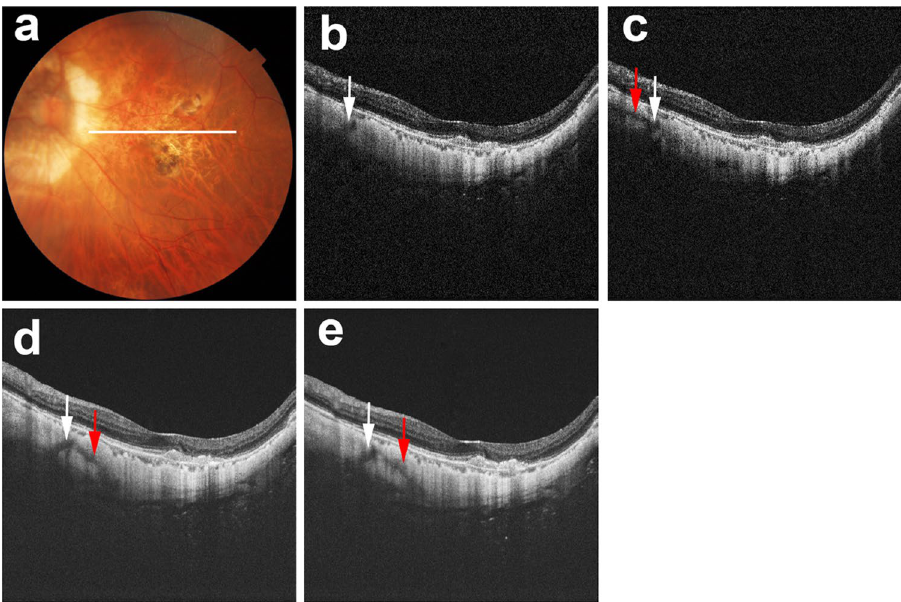
Figure 5. Scleral vessel artifacts in different locations in polarization-dependent OCT images and commercial OCT images. The left eye of a 75-year-old woman with myopic choroidal neovascularization in remission is shown. White line in color fundus image ( a ) indicates the scan line for PD-OCT images and commercial OCT B-scan images ( b – e ). Polarization-independent OCT B-scan image ( b ) shows a real scleral vessel (white arrow). Polarization-dependent OCT B-scan image ( c ) and two repeated commercial OCT B-scan images ( d , e ) also show real scleral vessels (white arrows). Along with the real scleral vessel, polarization-dependent OCT B-scan image ( c ) shows a scleral vessel artifact (red arrow). Two repeated commercial OCT B-scan images ( d , e ) show scleral vessel artifacts (red arrows) in locations that differ from the locations in polarization-dependent OCT images.